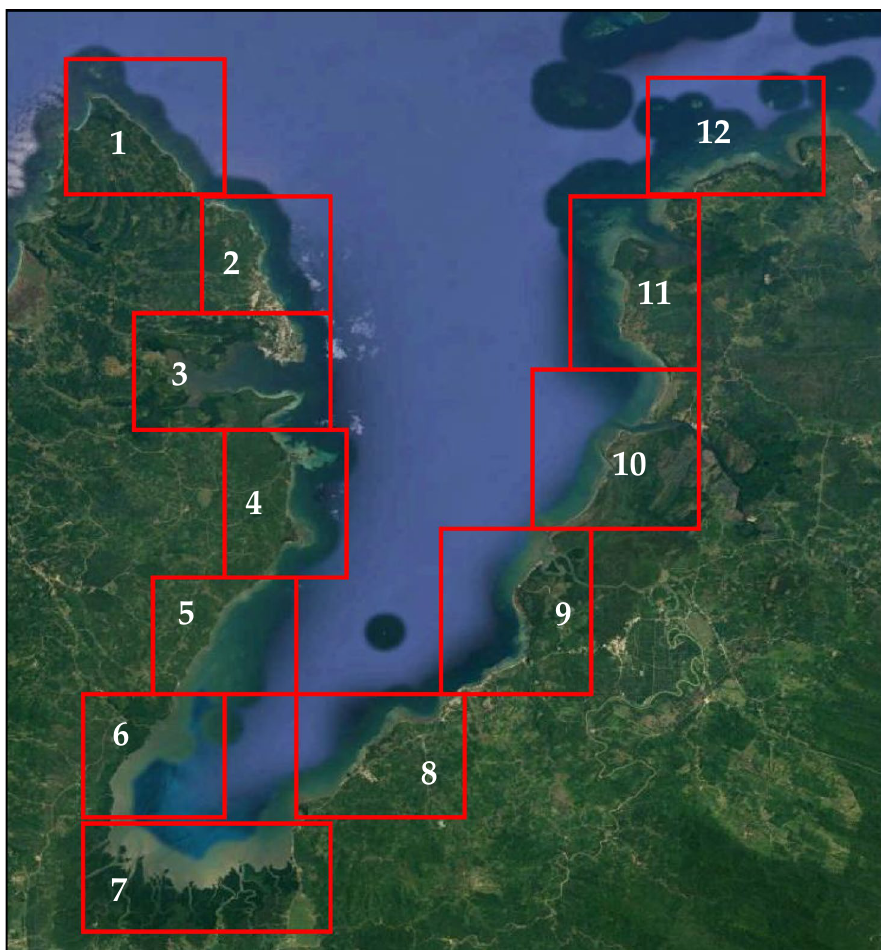
Fig. 1 The 12 zones of Marudu Bay for the vulnerability assess- ment due to climate